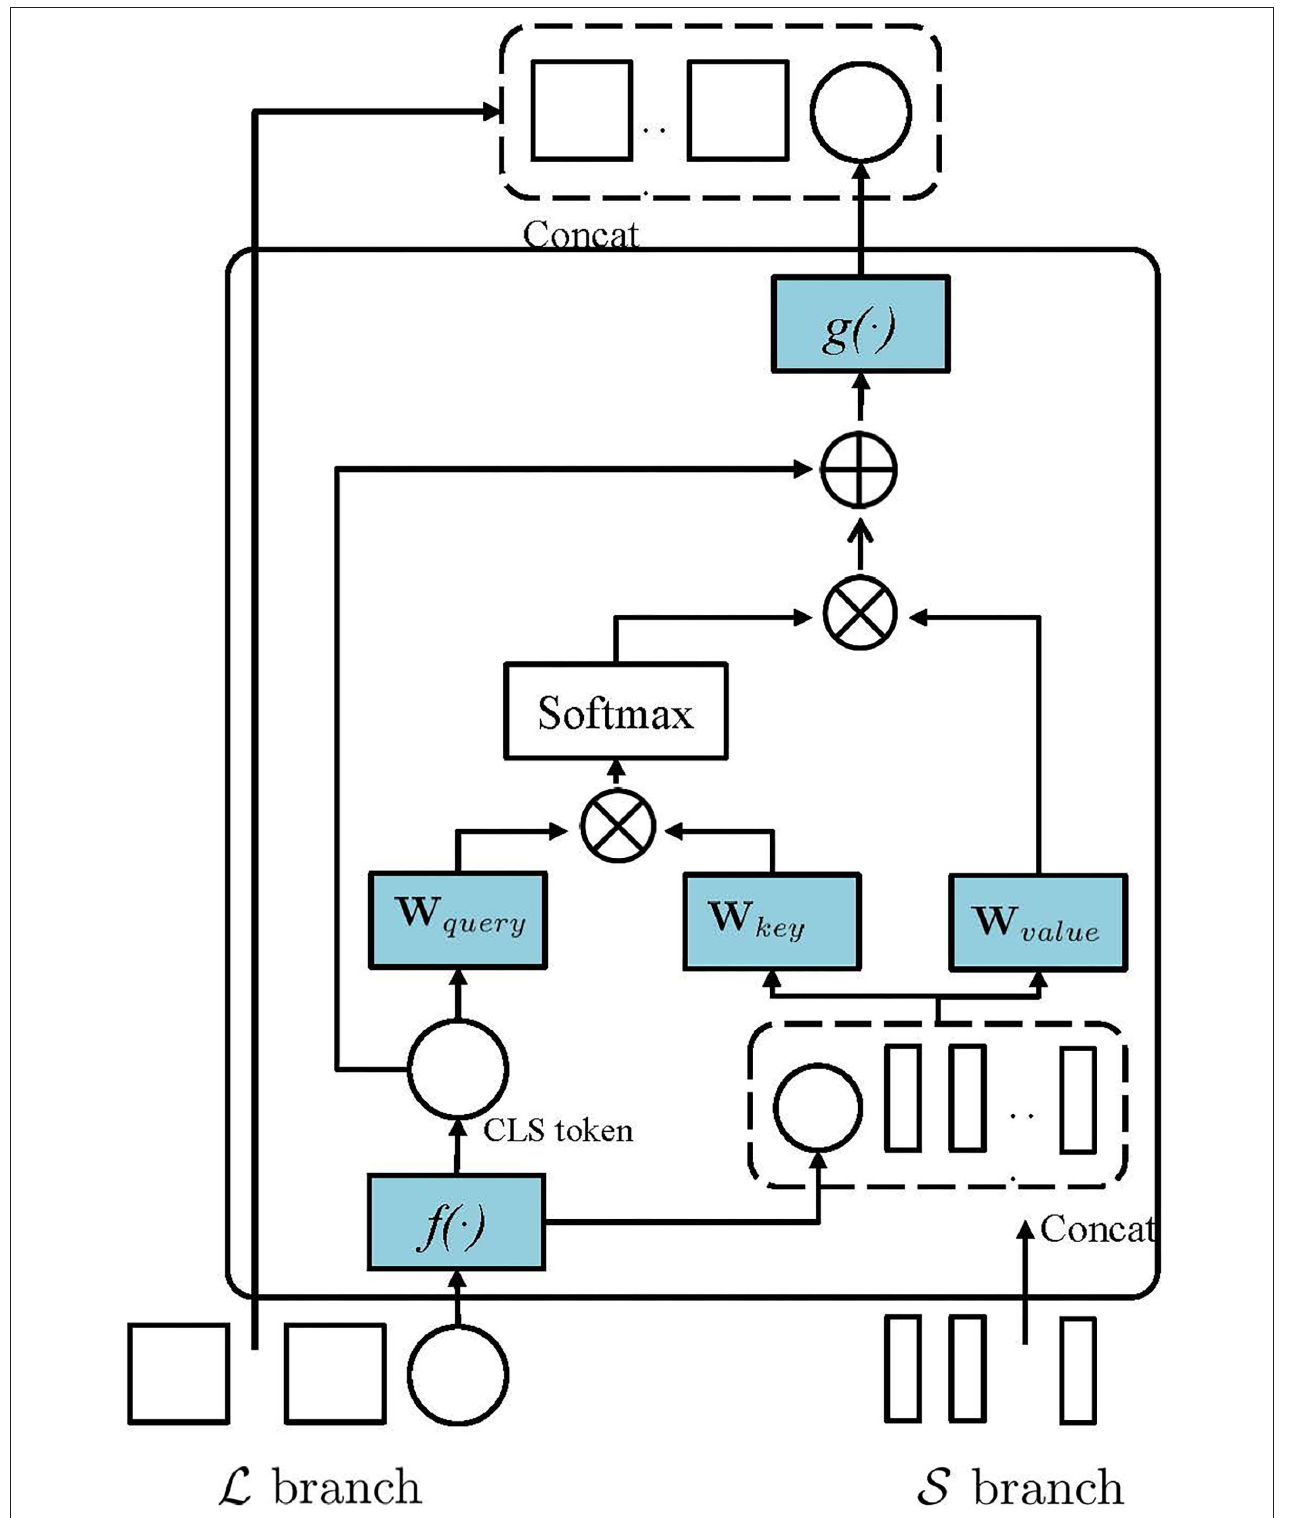
FIGURE 3 | The main idea of the cross-attention in PMVT. In this study, we show that PMVT utilizes the classification ( CLS ) token at the L branch as an agent to exchange semantic AU information among the patch tokens from the S branch. PMVT can also use the CLS token at S to absorb information among the tokens from the L